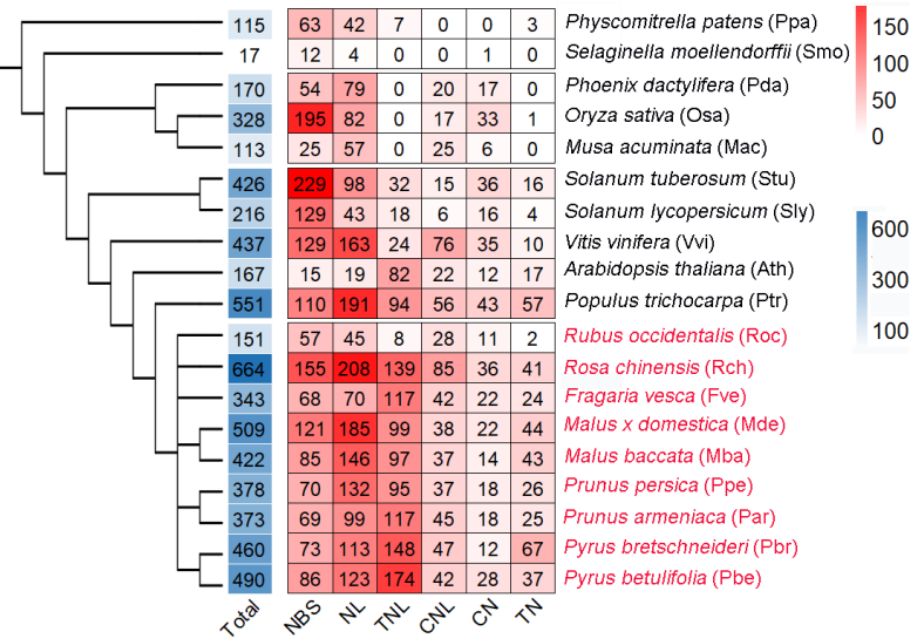
Figure 1. The number of Nucleotide-binding leucine-rich repeat (NLR) members varied between subfamilies and plant species.